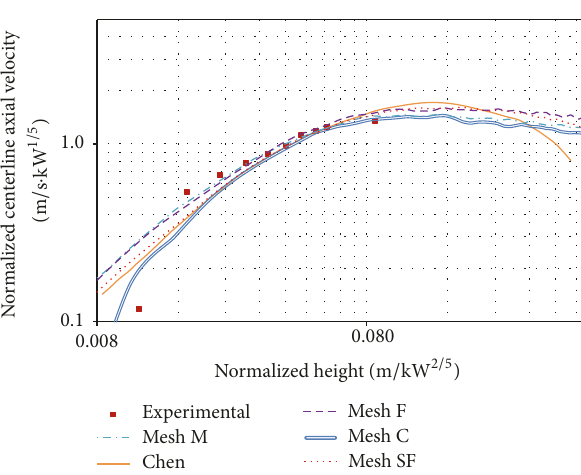
Figure10:Normalizedheight( 𝑧/𝑄 2/5 )versusnormalizedcenterline velocity ( 𝑢 𝑧 /𝑄 1/5